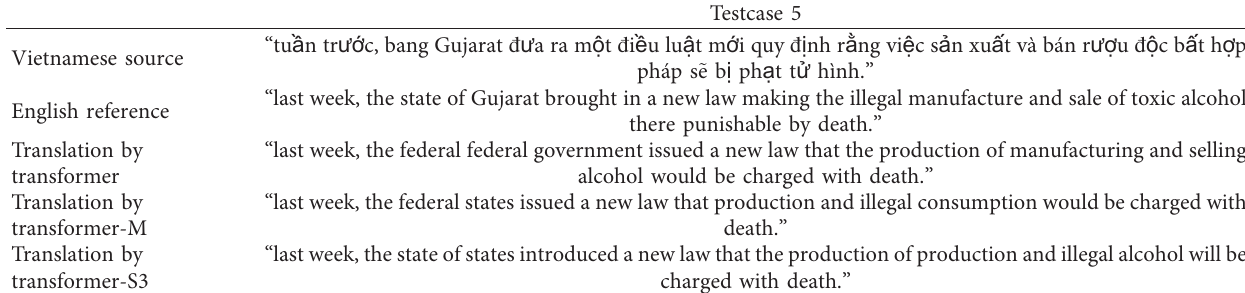
Table 11: Translations of a Vietnamese sentence comprising 30